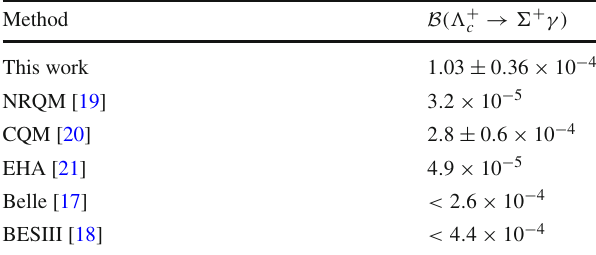
Table 2 Comparison of the branching fraction B ((cid:2) + c → (cid:3) + γ) from this work with those from the literature and the experiments